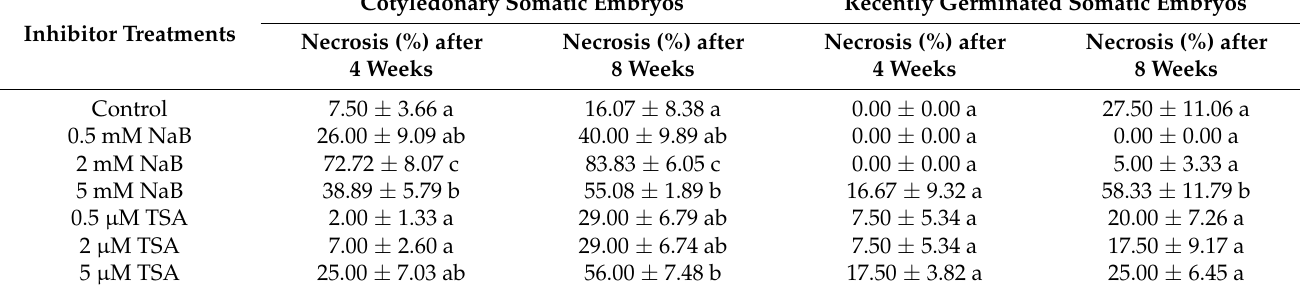
Table 1. Percentage of necrosis in grapevine (cv. Menc í a) cotyledonary and recently germinated somatic embryos that were cultured in an induction medium supplemented with different concentrations of HDAC enzyme inhibitors (NaB and TSA) or without them (control). Means and standard error are shown. Different letters indicate statistically significant differences ( p <